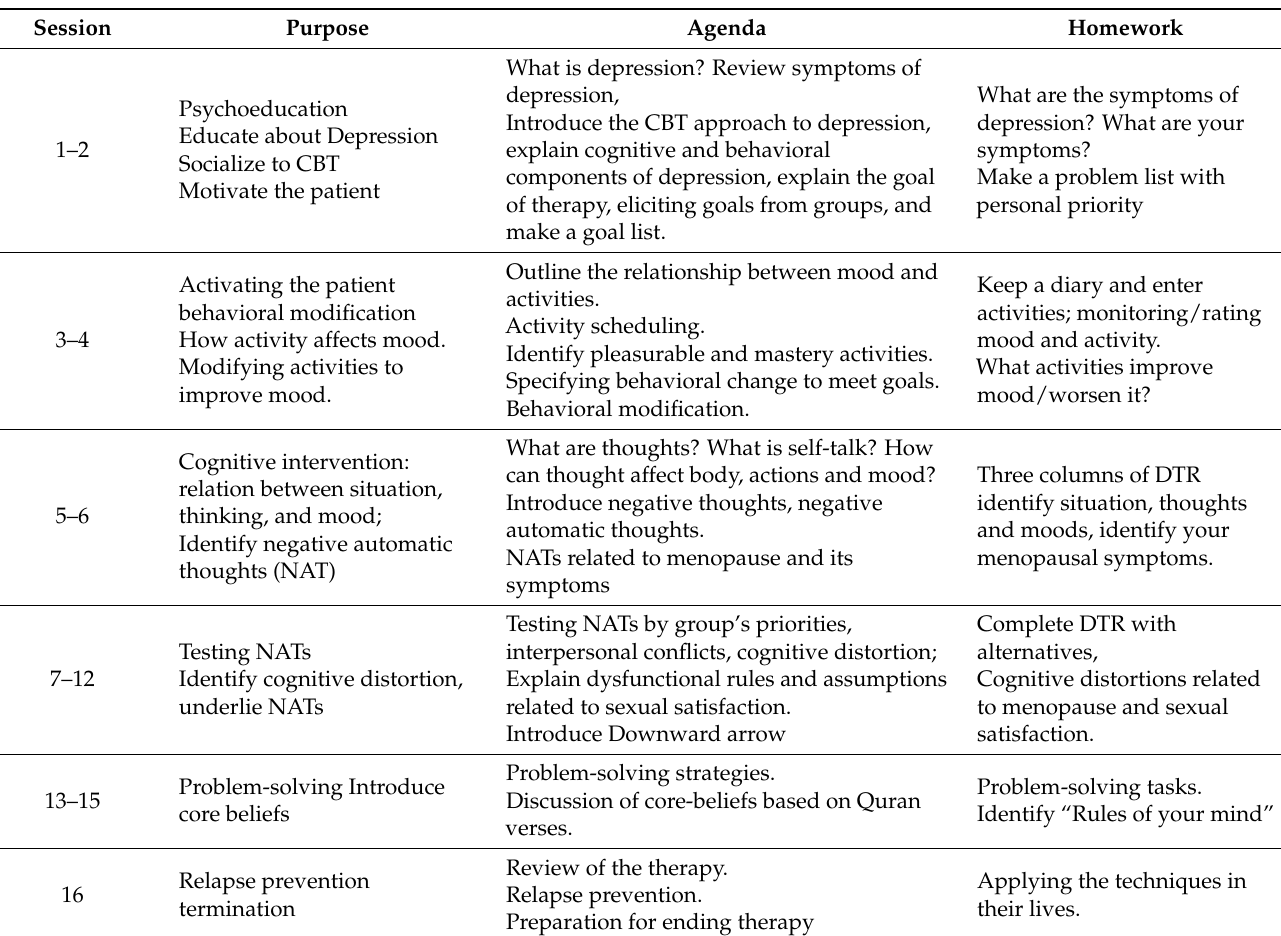
Table 1. Summary for treatment of culturally adapted Cognitive Behavioral Therapy (CA-CBT) on depression and marital sexual satisfaction for Iranian perimenopause